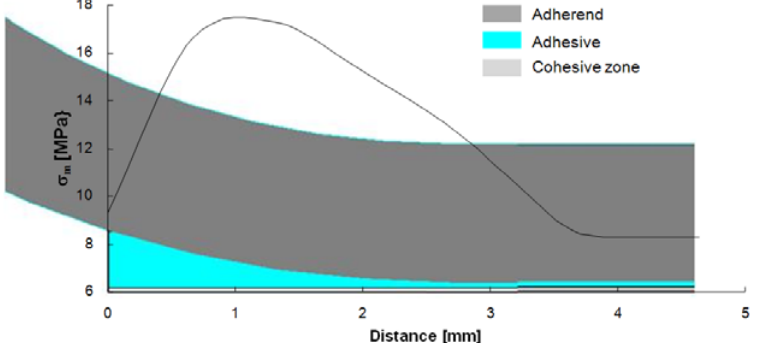
Figure 8: Distribution of cohesive strength (AACZ model) obtained as the value of stress in the adhesive normal to the plane of the joint, at the point in the analysis where the uniaxial failure strain was met locally.